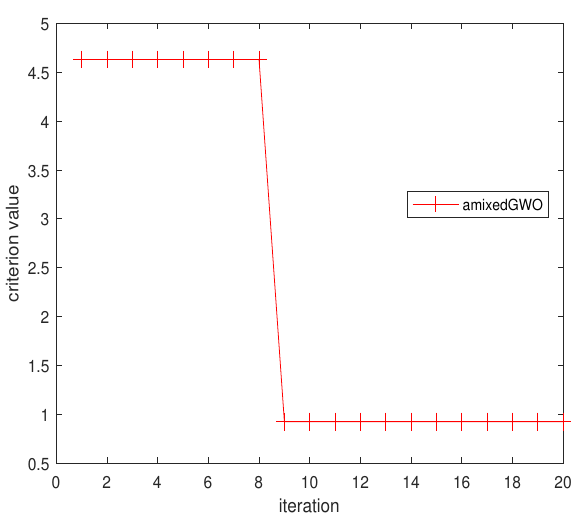
Figure 22. Convergence curve for amixedGWO, 36 acquisitions.